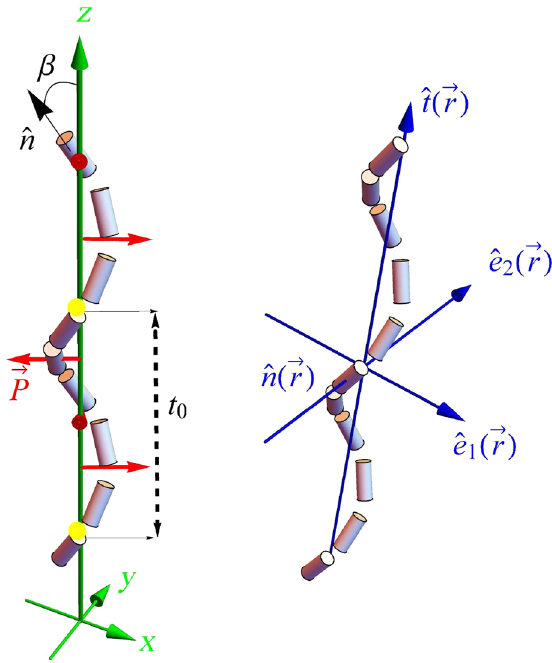
FIG. 1. Left diagram: Schematic representation of the N phase structure, showing heliconical director ˆ n (with cone angle β and helical pitch t 0 ) and helical polarization field P . Right diagram: Frame of reference used to describe spatial variations of the average director or pitch axis, ˆ t , on length scales much longer than the pitch (see Sec. IV). The orthogonal unit vectors ˆ e 1 and ˆ e 2 form a right-handed system with ˆ t . The xyz axes are fixed in the laboratory